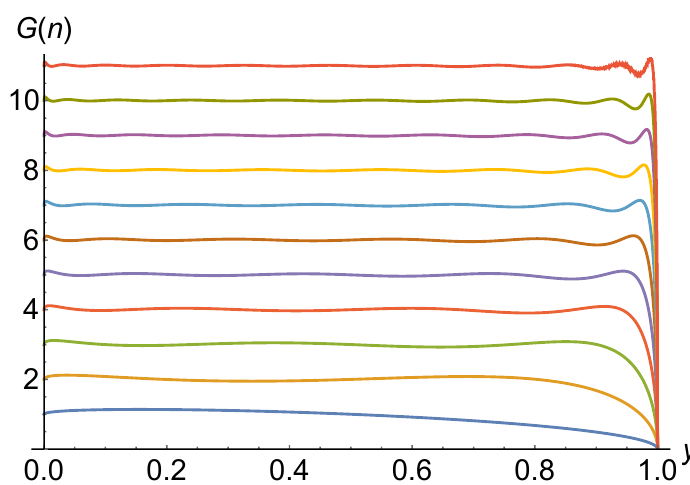
π F p n q , for n “ 1,...,11. At y “ 0, θ c c